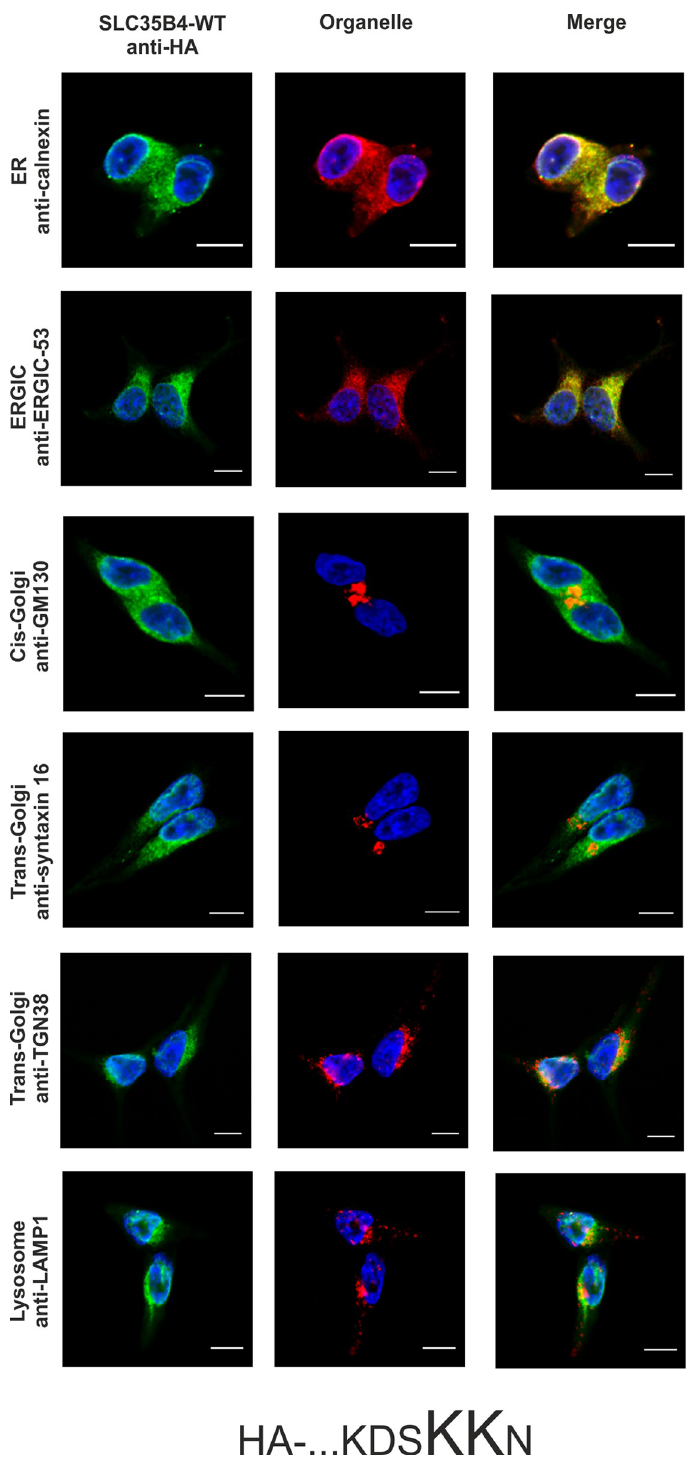
Fig 1. Subcellular localization of HA- ... KDSKKN, human SLC35B4 with HA-epitope at the N-terminus in the wild-type HepG2 cells. Stably transfected wild-type (SLC35B4-WT) cells, overexpressing SLC35B4 variants, were subjected to indirect immunofluorescent staining with anti-HA (green) and anti-organelle markers (Table 3) (red) antibodies. Cell nuclei were counterstained with DAPI. Scale bar 10 μ m.